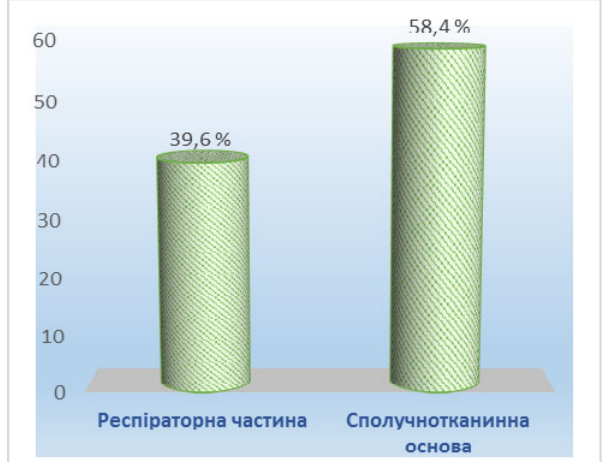
Fig. 7. Histological structure of the lungs of a mature rabbit; 1 – lumen of the small alveoli; 2 – lumen of the middle alveolus; 3 – lumen of the large alveoli; 4 – in- teralveolar membranes. Hematoxylin and eosin. Х. 280